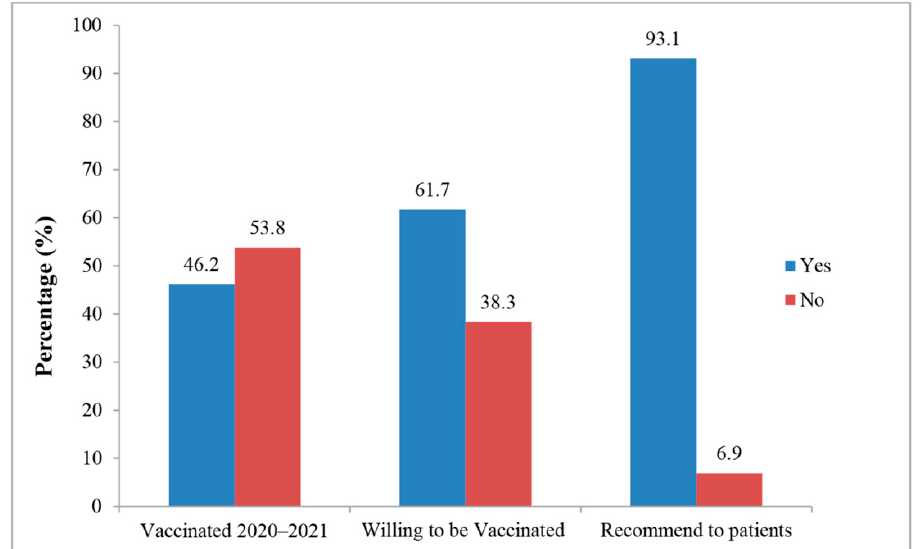
Figure 3. The proportion of community HCWs vaccinated, willing to vaccinate, and willing to recommend the influenza vaccine to patients.